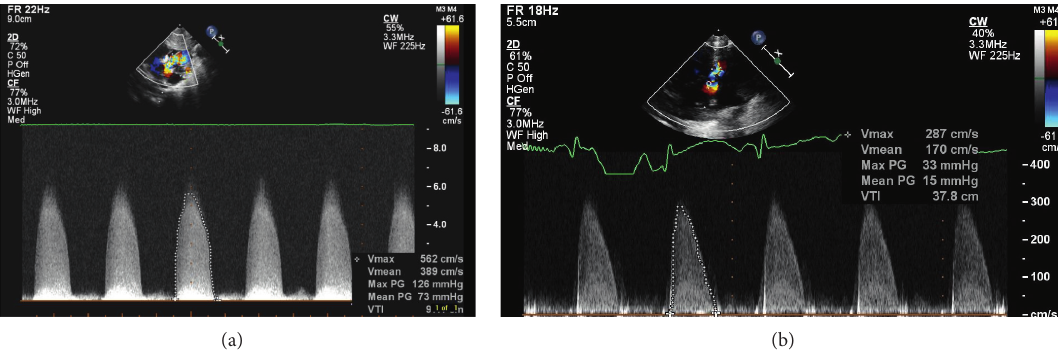
Figure 1: (a) An example of echocardiography preballoon angioplasty, continuous-wave spectral Doppler across the aortic valve in a newborn showing severe aortic stenosis with a mean gradient 73mmHg and a peak systolic gradient 126mmHg. (b). Echocardiography postballoon angioplasty, continuous-wave spectral Doppler across the aortic valve revealing marked decrease in the degree of aortic stenosis to a mean gradient of 15mm Hg and a peak systolic gradient of 33mmHg.